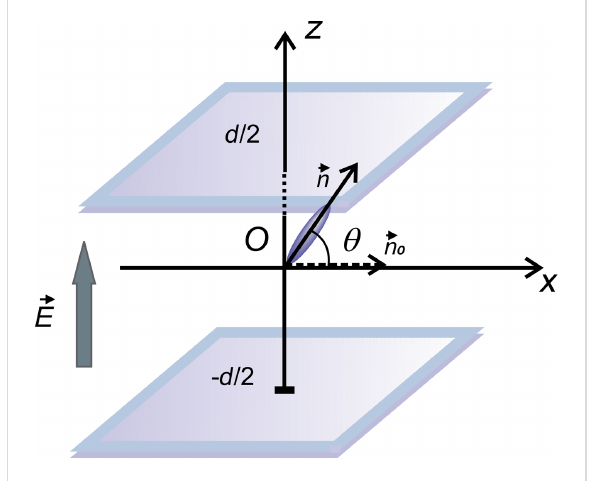
Figure 1: Liquid crystal molecular orientation inside a LC cell exposed to an electric field. is the undisturbed molecular director and is the molecular director when the electric field is